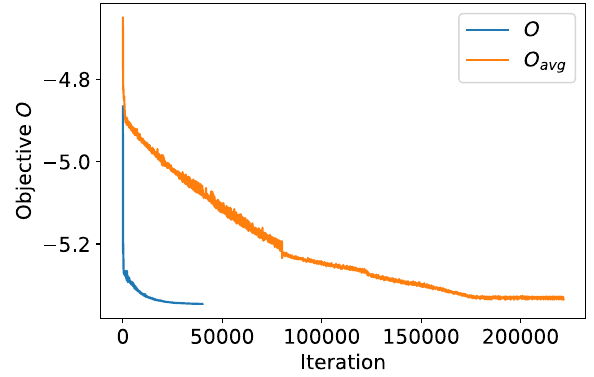
Fig. 3 iSWAP gate optimization loss during training. The blue curve corresponds to the optimization of O in Eq. (5) and the orange curve corresponds to O avg in Eq. (15). The curves are smoothed using the Savitzky – Golay fi lter. The optimization of O avg is interrupted and continued again at iteration 80000 (see Supple- mentary Note V for more discussion).